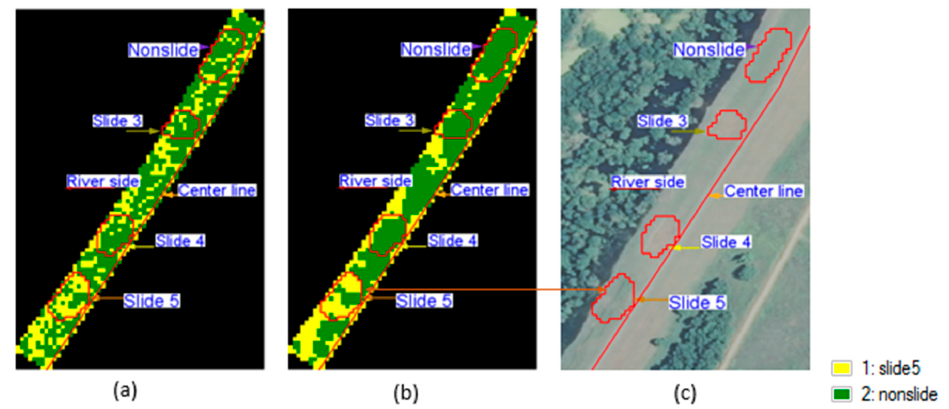
Figure 12. Magnitude data classification for the segment Sample 3: ( a ) without majority filter; ( b ) with majority filter; ( c ) optical image overlaid with slide and nonslide class shapes.